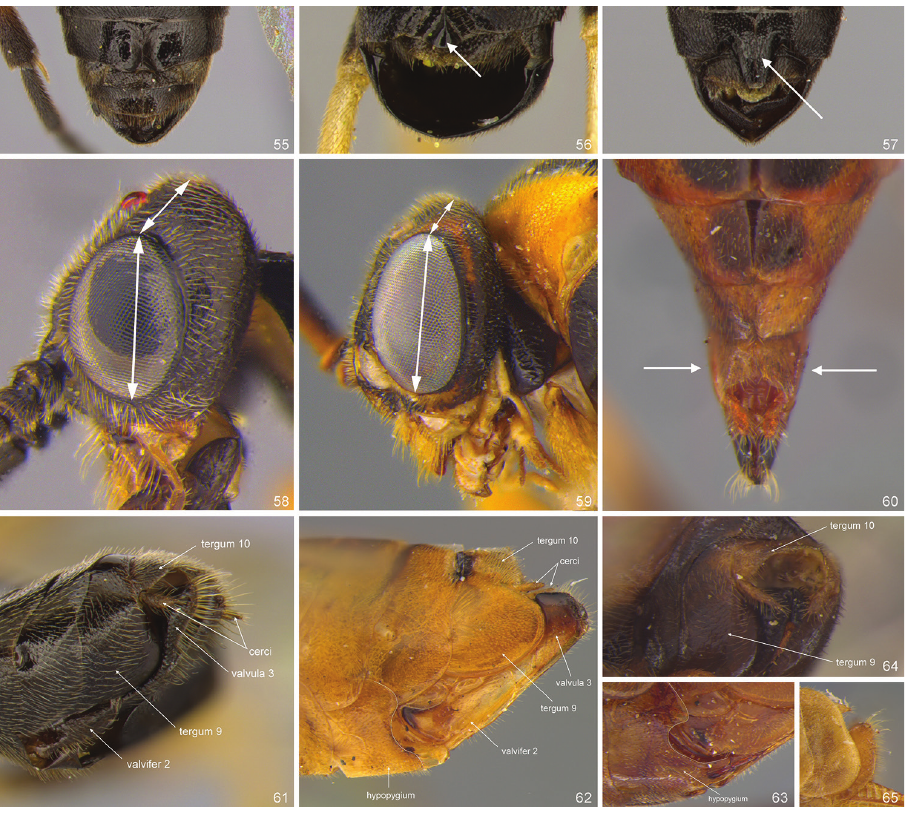
Figures 55–65. External characters used to identify Pristiphora species. 55 subopaca DEI-GISHym31560 56 leucopodia DEI-GISHym80057 (arrow indicates an indistinct apical projection of the tergum 8) 57 arma- ta DEI-GISHym11092 (arrow indicates a distinct apical projection) 58 malaisei DEI-GISHym10991 (arrows indicate small eyes relative to head length above eyes) 59 testacea DEI-GISHym19770 (arrows indicate large eyes relative to head length above eyes) 60 saxesenii DEI-GISHym20844 (arrows indicate lateral constriction of the apex of the abdomen) 61 appendiculata DEI-GISHym31500 62 pseudodecipiens DEI-GISHym20999 63 decipiens DEI-GISHym21256 64 laricis DEI-GISHym31503 65 alpestris